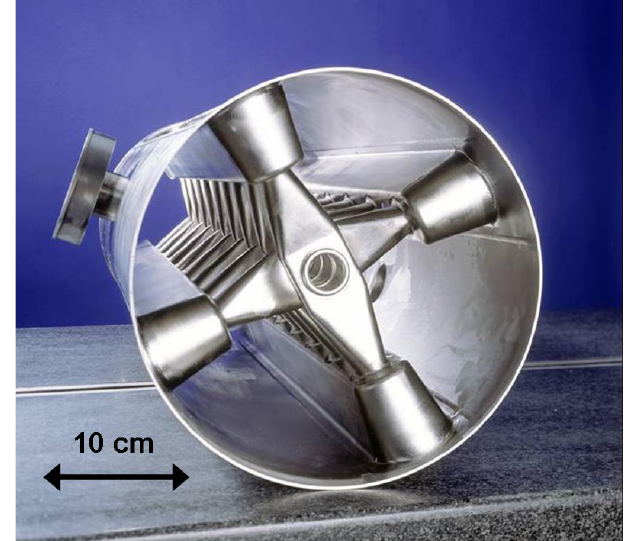
FIG. 1. (Color) View into the superconducting CH cavity, (cid:1) (cid:1) 0 : 1 , f (cid:1) 360 MHz , before welding of the end walls